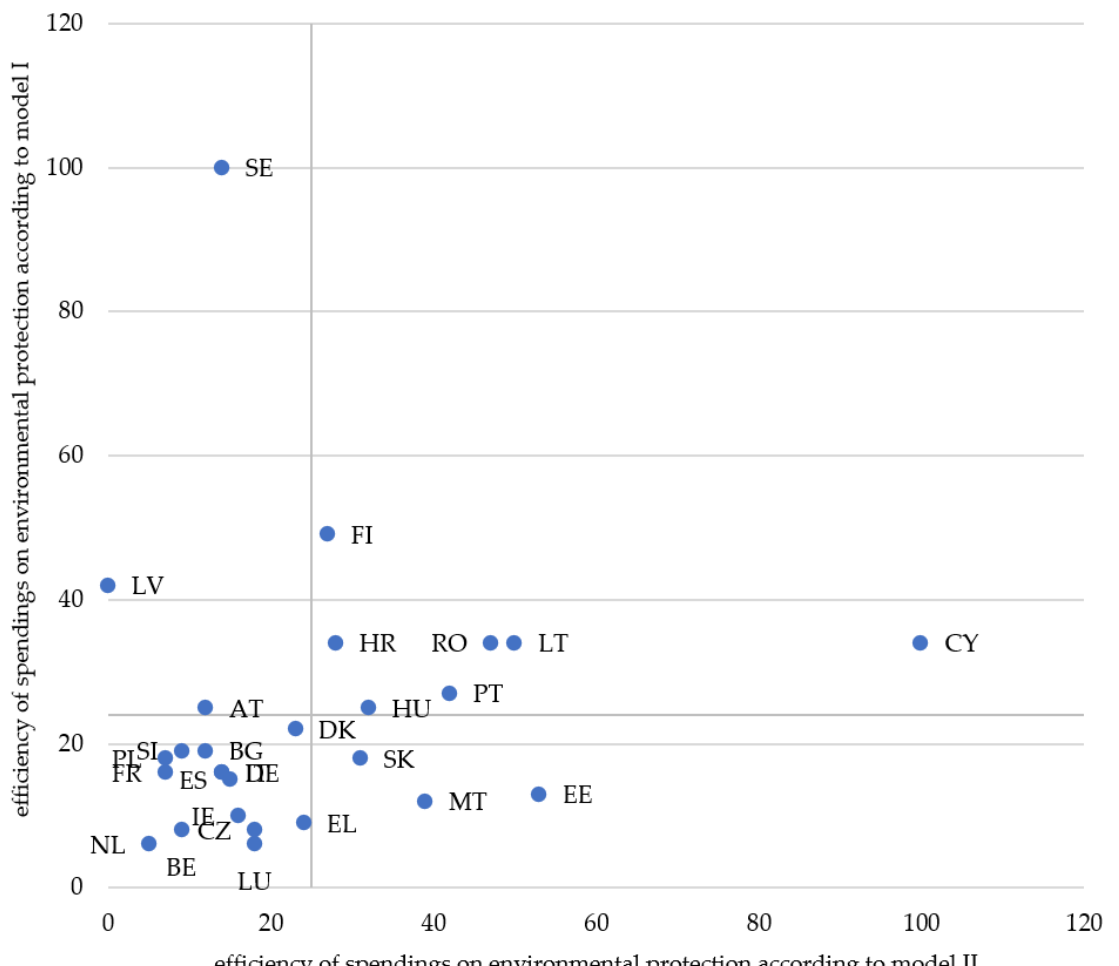
Figure 3. Countries in terms of nominal expenditure efficiency and in % GDP in decreasing emissivity. Source: own elaboration based on DEA results.